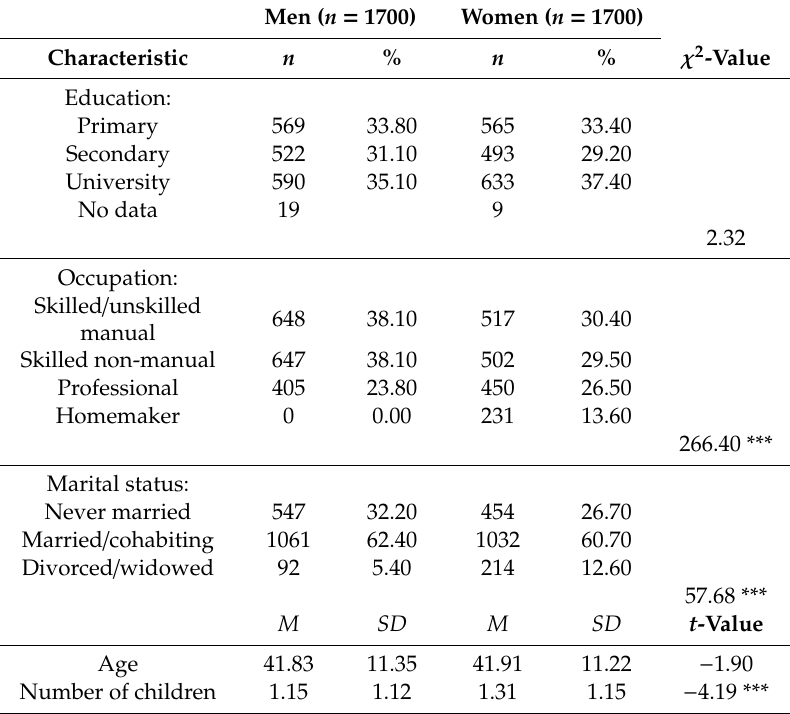
Table 1. Demographic characteristics of the men and women